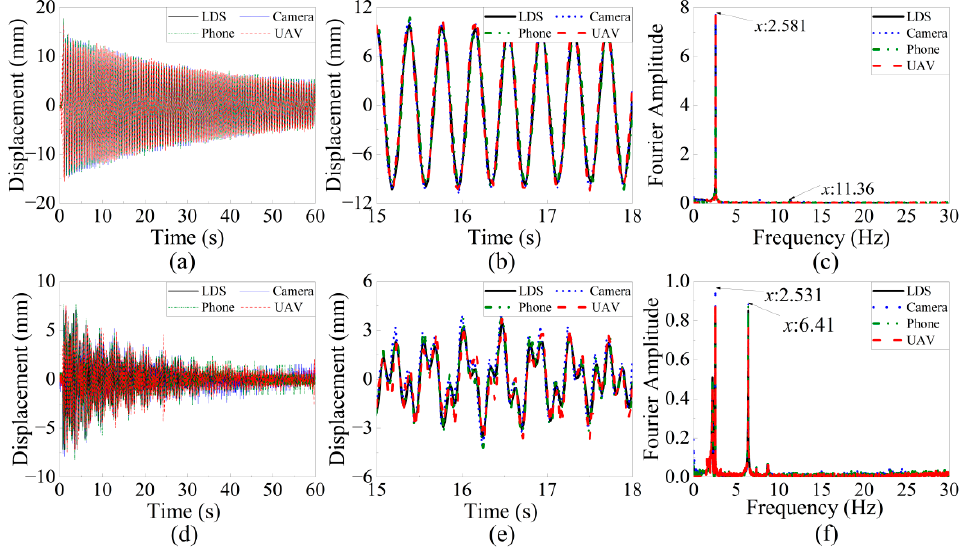
Figure 21. Wind turbine vibration time domain and frequency domain monitoring comparison: ( a – c ) edgewise direction; ( d – f ) flap-wise direction.